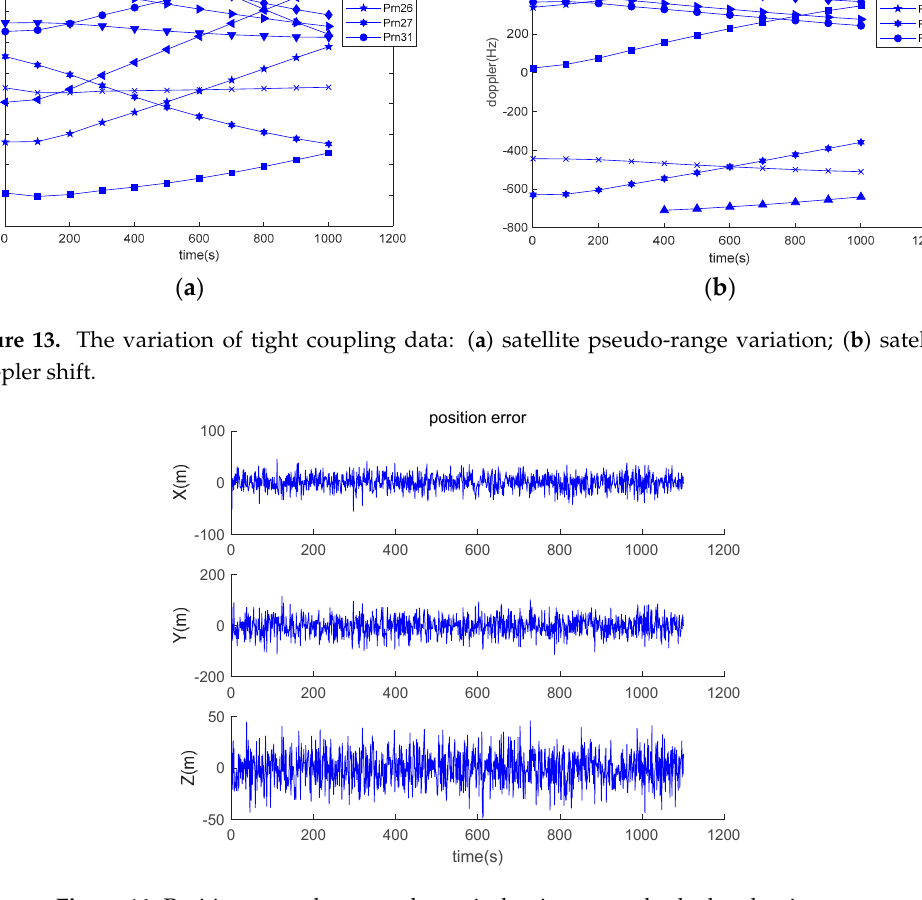
Figure 14. Position errors between theoretical trajectory and calculated trajectory.